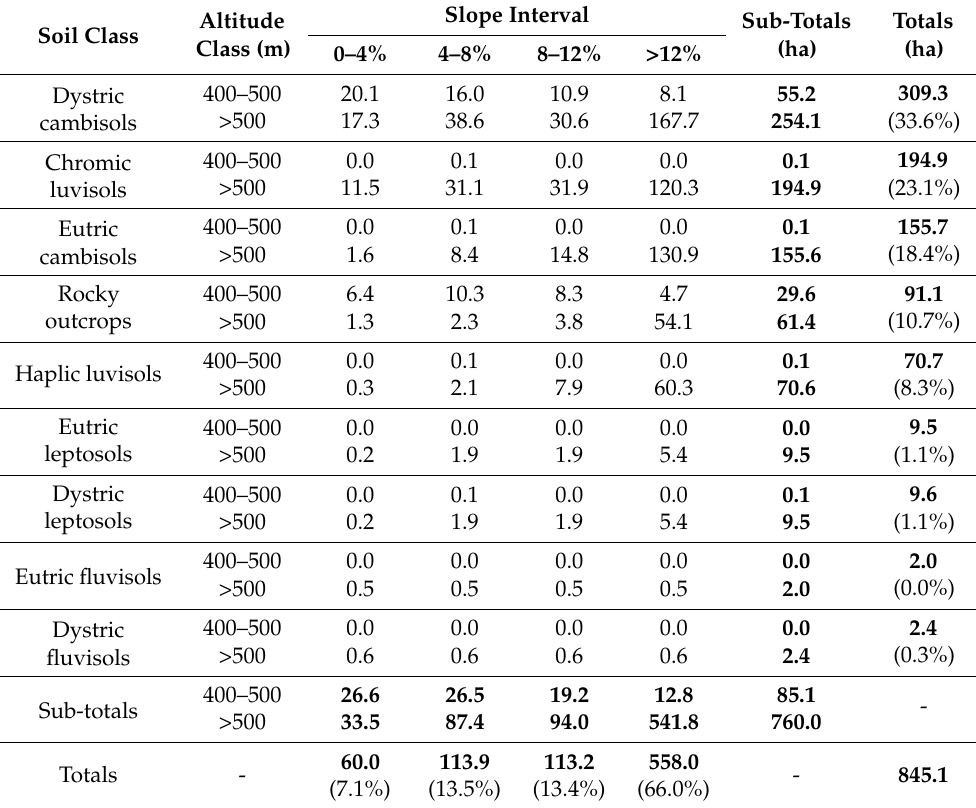
Table 4. Current chestnut area (ha) by soil, slope, and